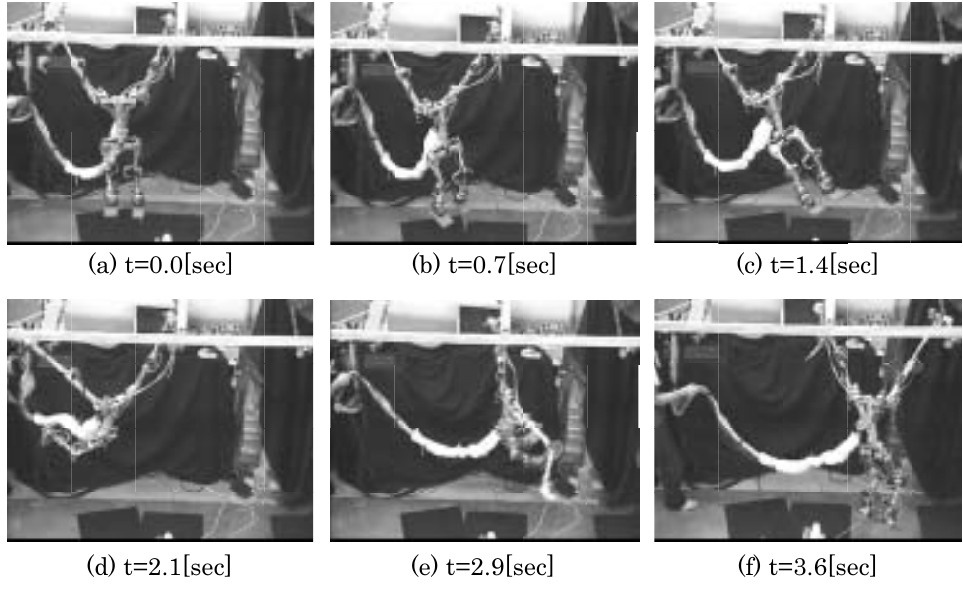
Figure 20 Stroboscopic photography of side-hand brachiation.